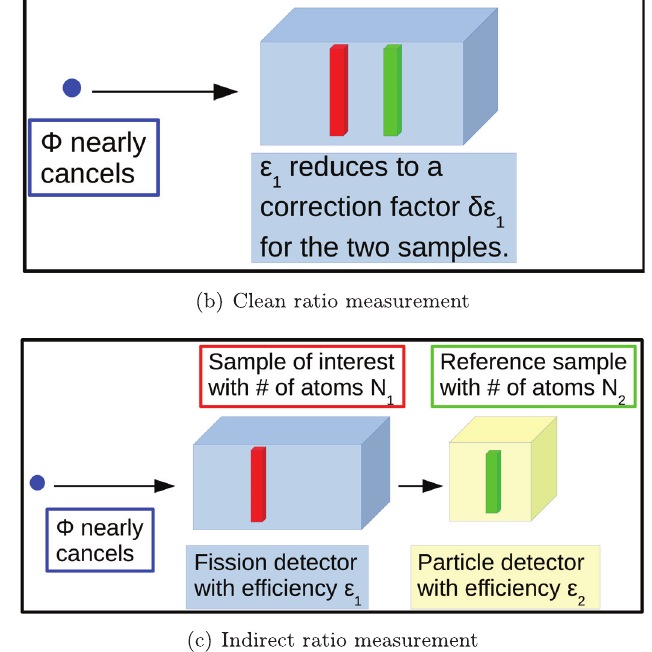
Fig. 3. Typical measurement techniques for absolute (upper panel), clean (middle panel) and indirect ratio (lower panel) measurements are schematically